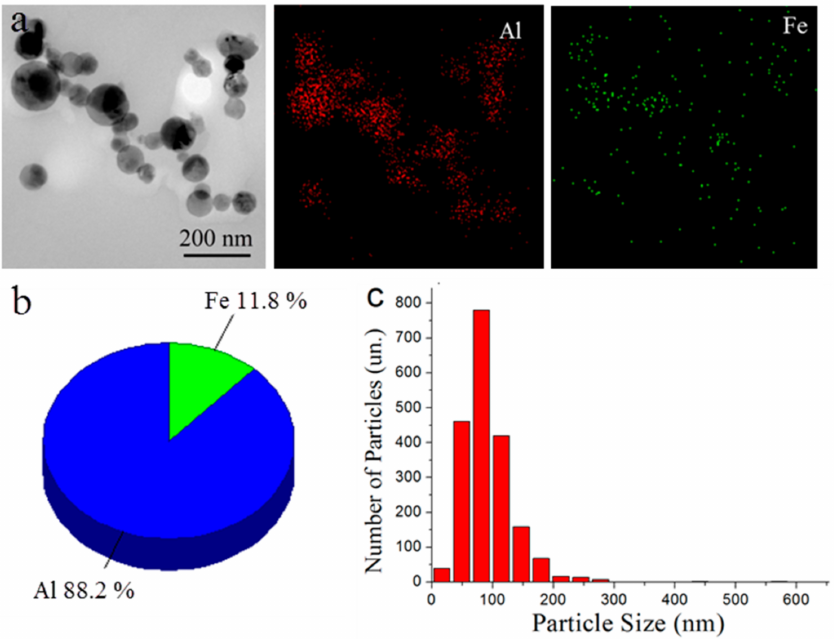
Figure 1. TEM images and elemental distribution maps ( a ), elemental mass distribution ( b ) and size distribution curve ( c ) of Al/Fe